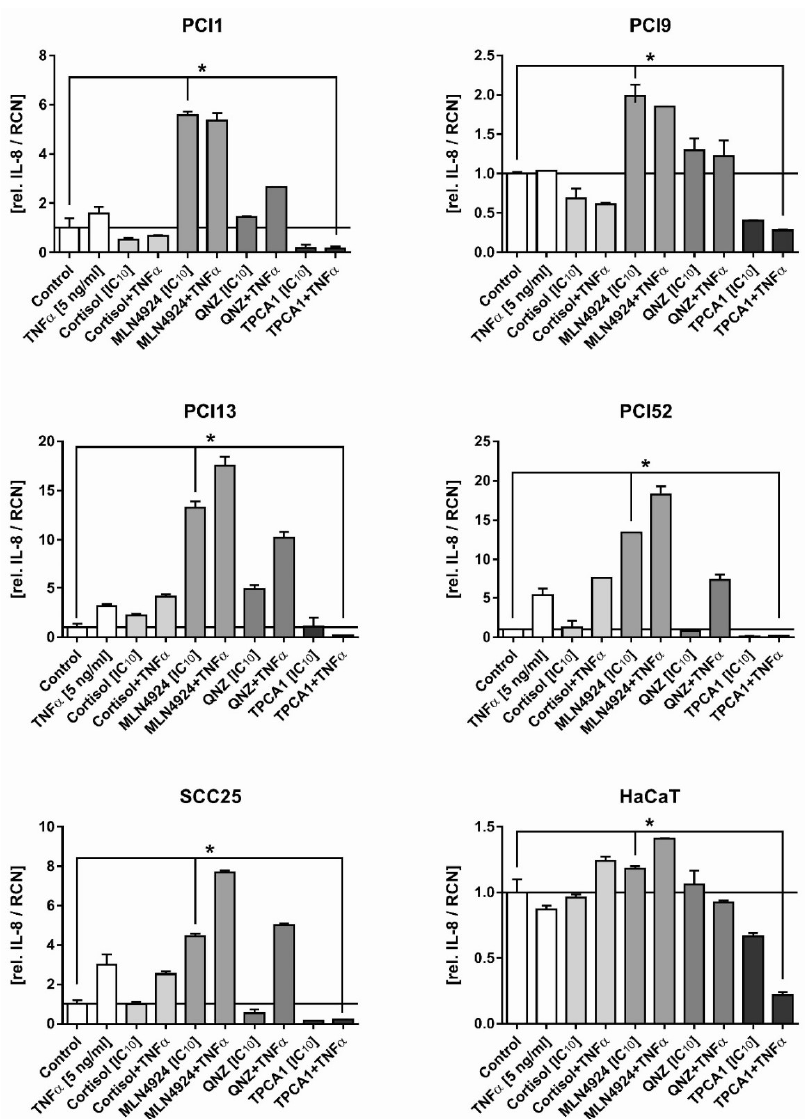
Figure 3. IL-8 secretion from HNSCC cell lines after incubation with the NF κ B inhibitors Cortisol, MLN4924, QNZ and TPCA1 alone and in combination with TNF α . Cells (2 × 10 4 /well) were preincubated for 6 h with the appropriate IC 10 of each inhibitor and subsequently incubated for an additional 48 h with and without TNFα (5 ng/mL). IL-8 values were normalised to RCNs determined in a crystal violet assay of the corresponding 96-well plate, as described in the material and methods section. Representative results from a total of three independently reproduced experiments ( n = 3) are presented. The Wilcoxon rank-sum test was used for statistical data evaluation. p < 0.05 depicts statistically significant IL-8 inducing or inhibiting effects of the indicated treatment by taking the corresponding cell proliferation into account marked by *.